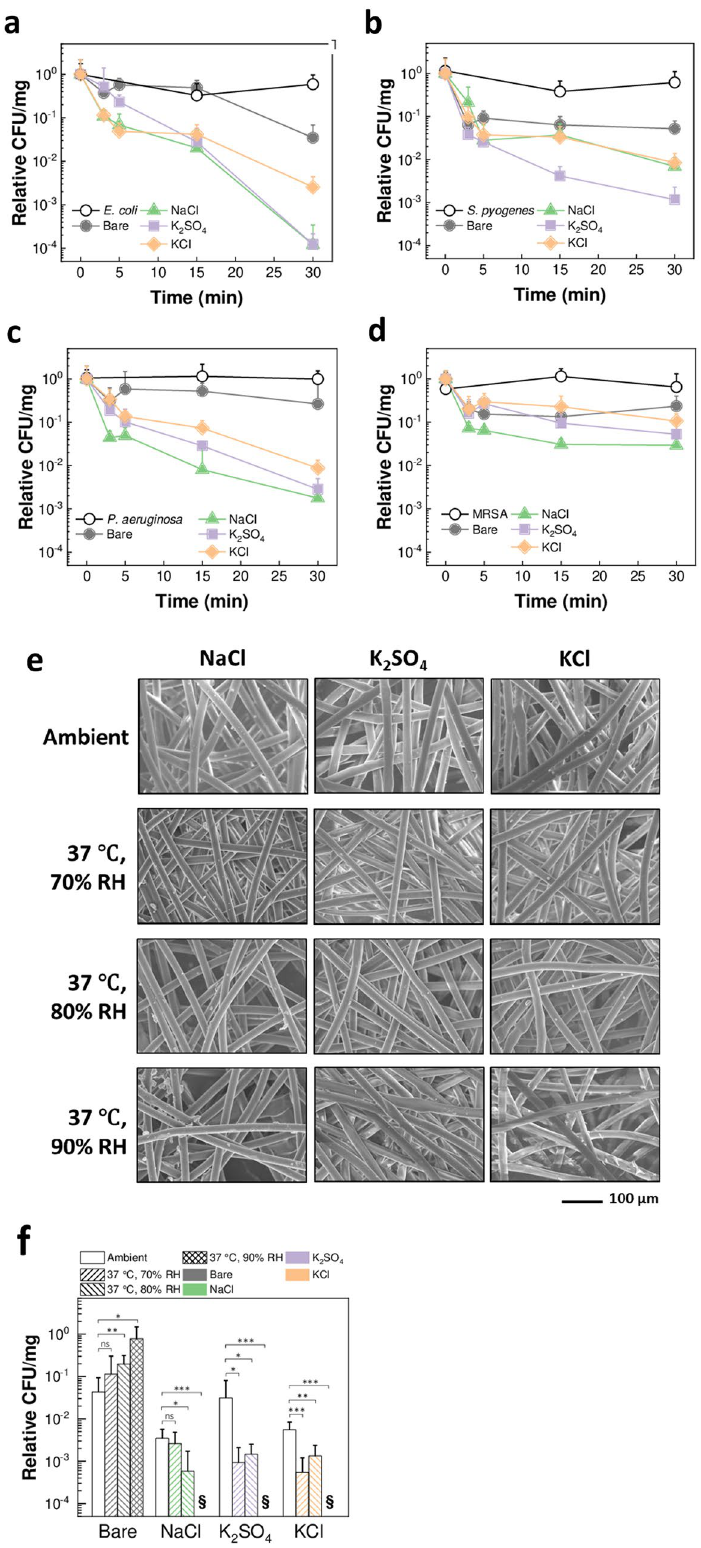
Figure 3. Strain-nonspecific protective efficacy and environmental stability. ( a – d ) CFU change showing the effect of incubation time on E. coli ( a ), S. pyogenes ( b ), P. aeruginosa ( c ), and MRSA ( d ) exposed to bare membranes and NaCl, K 2 SO 4 , and KCl filters ( n = 4–19 for ( a ), n = 3–19 for ( b ), n = 3–25 for ( c ), n = 2–10 for ( d ), mean ± SD). ( e ) SEM images of NaCl × 3 600 , K 2 SO 4 × 3 600 , and KCl × 3 600 at ambient condition (top), and following 5-days storage at 37 °C and 70%, 80% and 90% RH. ( f ) CFU change showing the effect of temperature and humidity (5-days storage) on bare membranes and NaCl, K 2 SO 4 , and KCl filters in inactivating K. pneumoniae after 30-min incubation ( n = 3–10, mean ± SD). §: below detection limit. ns: P > 0.05; * P < 0.05; ** P < 0.01; **** P < 0.0001, by t